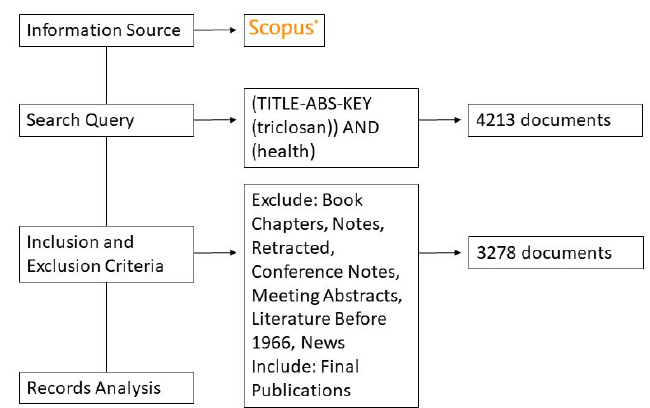
Figure 1. Data Collection and